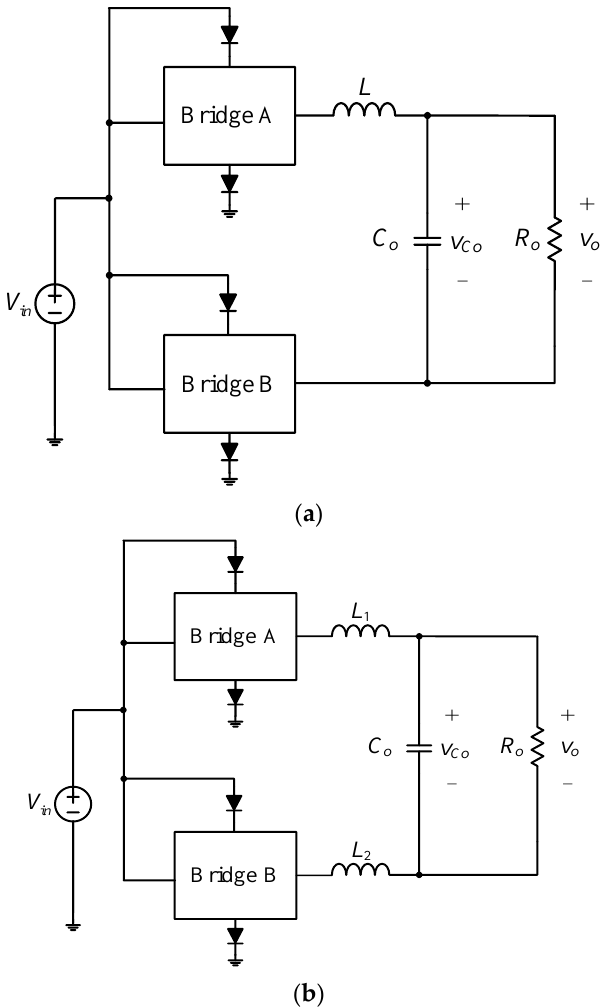
Figure 10. Filter circuit diagram from the point of view of the output load with the inductance of ( a ) L ; ( b ) L 1 and L 2 .